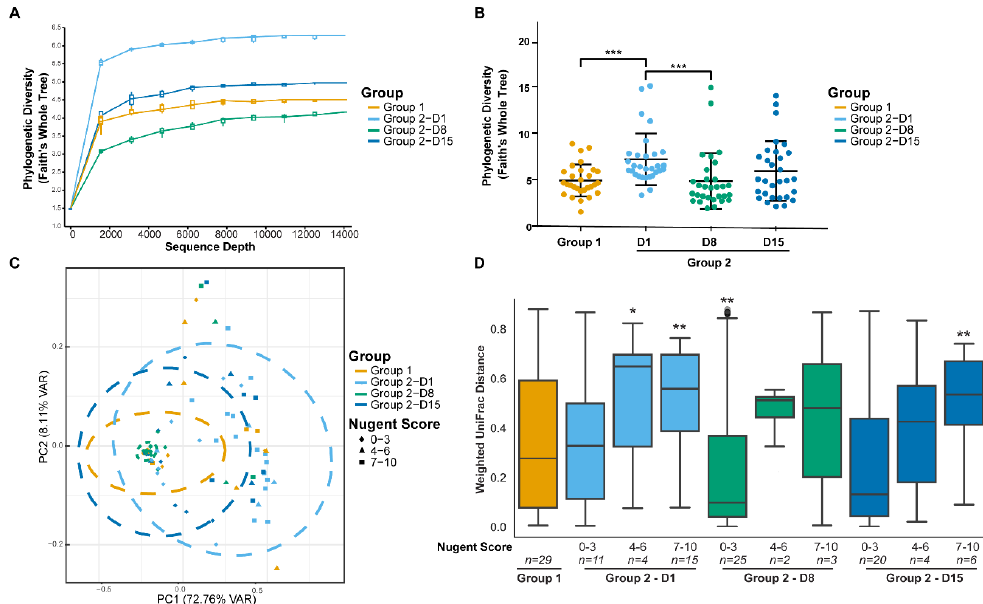
Figure 3. Alpha diversity of vaginal microbiota samples from individuals plotted as rarefaction curves ( A ) and compared between study groups and day using the phylogenetic diversity (Faith’s whole tree) metric ( B ). Beta diversity (weighted UniFrac metric) showing clustering of the vaginal microbiota communities from individuals by study group, day, and Nugent score in a principal coordinate analysis (PCoA) plot ( C ) and distances between Group 1 and Group 2 time points subgrouped by Nugent scores ( D ). Ellipses represent 95% confidence interval. *** FDR < 0.001, ** FDR < 0.01, * FDR < 0.05; Kruskal-Wallis